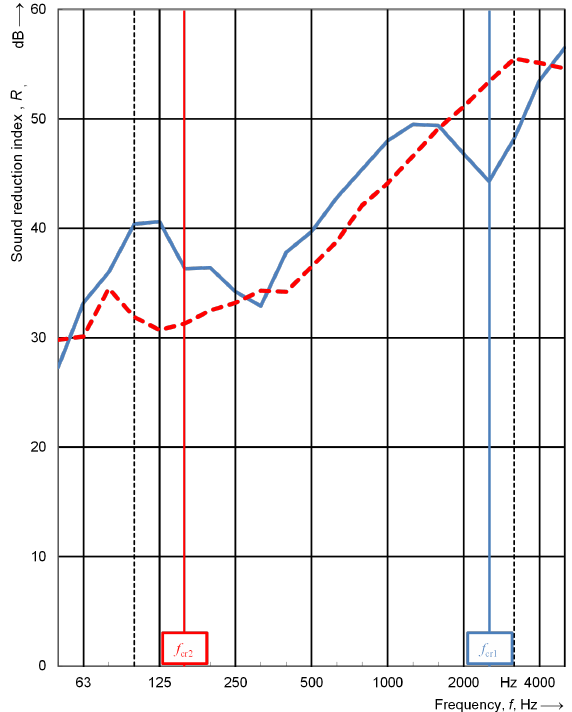
Figure 5. Sound reduction index of walls: timber with recycled infill – the solid blue curve, masonry – the dashed red curve.